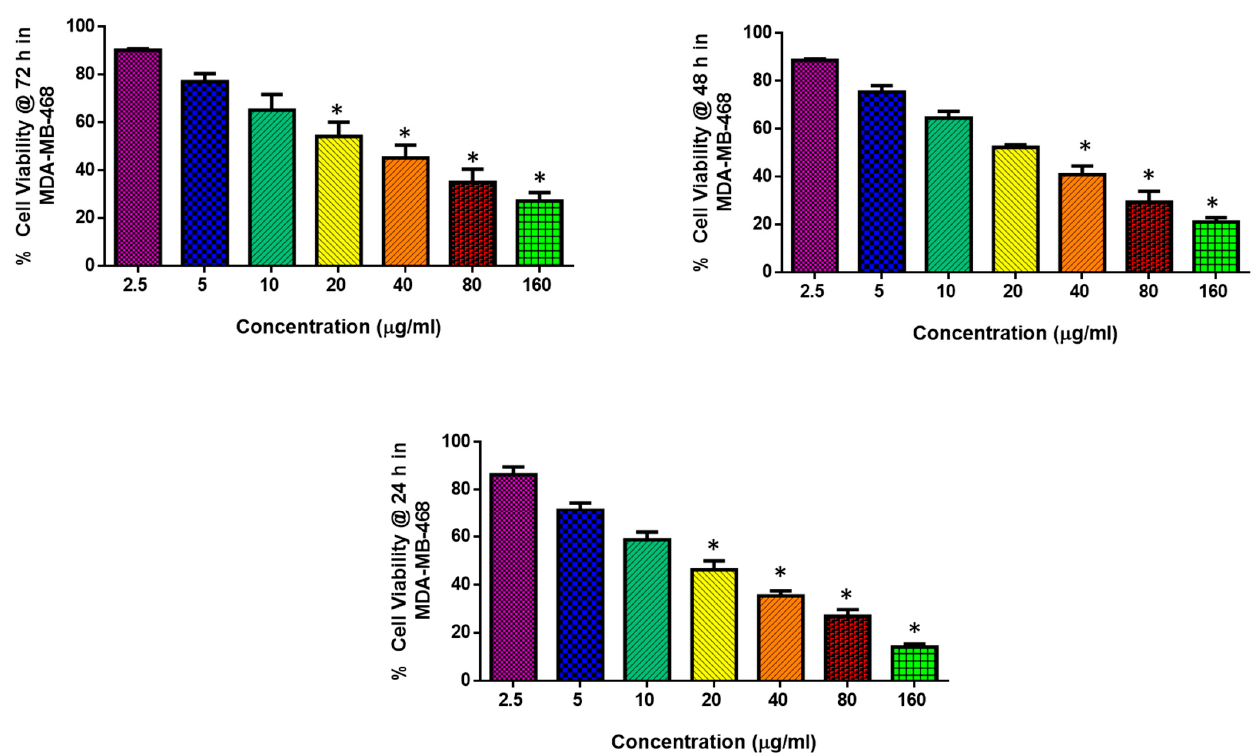
Figure 3. Albumin visnagin NPs cause cytotoxicity in MDA-MB-468 cells. Cells were treated with various concentrations (2.5–160 µg/mL) of albumin visnagin NPs for 24, 48, and 72 hrs and the viability was assessed by MTT assay. Data are illustrated as mean ± SD of triplicates. * Signifies p < 0.05 when compared with control.